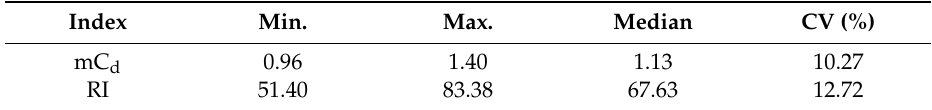
Figure 7. The gross domestic product of Haixi state, gross industrial production of Haixi state, and gross industrial production of Qinghai Salt Lake Industry Group Co. [67]. Table 4. The basic statistical parameters of the modified degree of contamination (mC d ) and potential ecological risk index